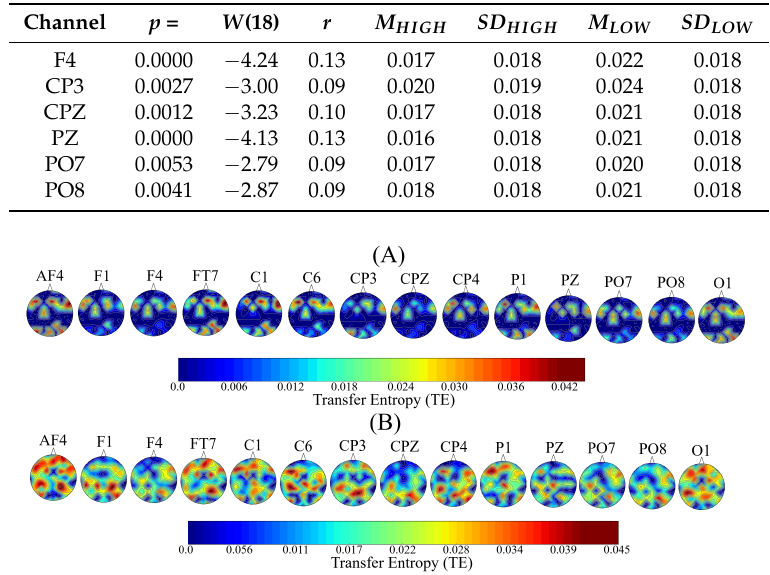
Figure A5. Eyes-Open (EO) setting. Global distribution of TEs of channels whose total TE values significantly differed between HIGH and LOW Stress-Susceptible Groups. These channels were AF4, F1, F4, FT7, CP3, CP4, CPZ, C1, C6, P1, PZ, PO7, PO8, and O1. ( A ) HIGH stress-susceptible group ( B ) LOW stress-susceptible group. This figure indicates that distributed TEs from these channels were primarily contributed to the frontal regions in the case of HIGH stress-susceptible group. On the other hand, their contribution was more globally distributed among fronto-parietal in the case of LOW stress-susceptible